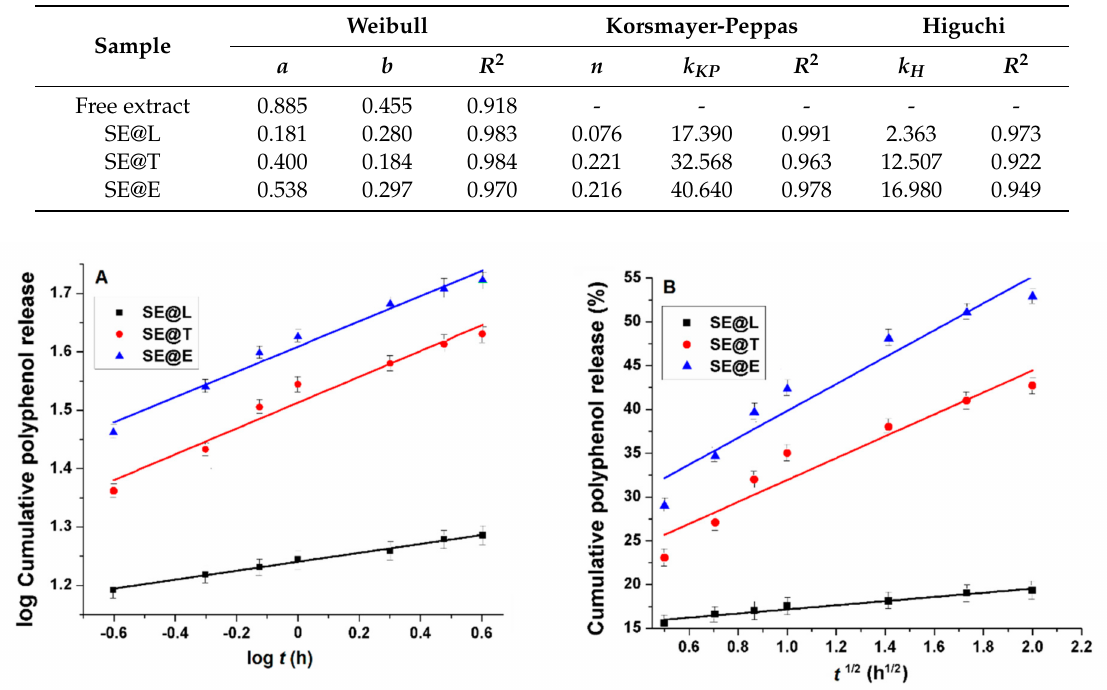
Figure 5. Polyphenols release profiles from SE extract-loaded lipid vesicles fitted with the Korsmayer-Peppas ( A ) and Higuchi ( B )